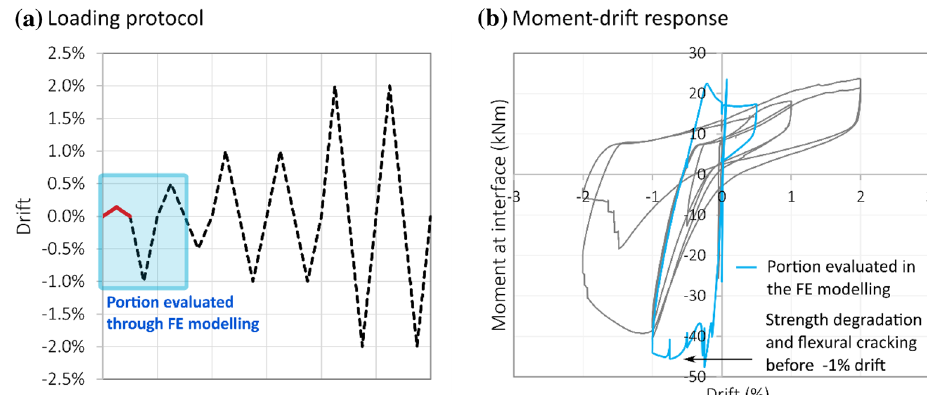
Fig. 8 Connection tested for